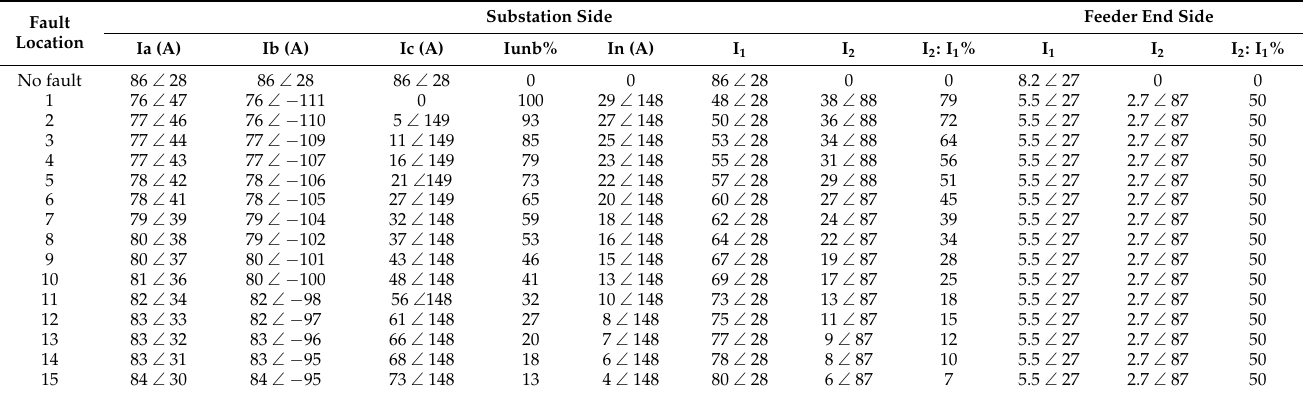
Table 2. Distribution of the load for the case study. Connected Load Transformer Capacity (kVA) Table 3. The measurements at substation and feeder